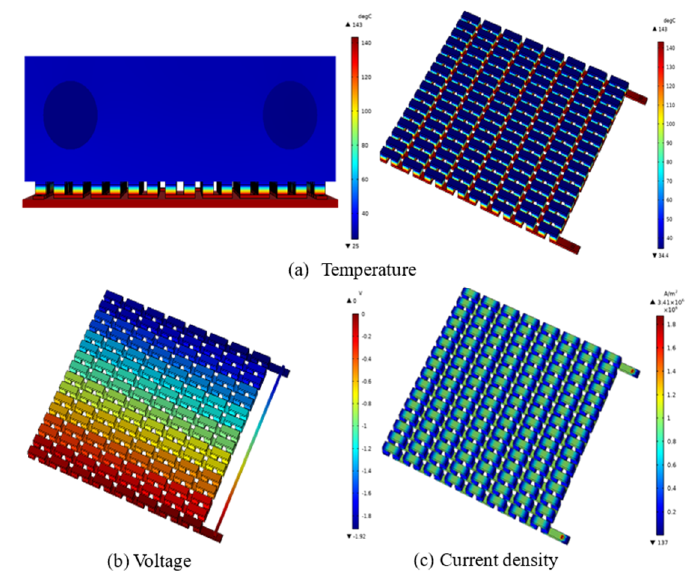
Figure 6. Numerical results of the TEG system. ( a ) Temperature distribution. ( b ) Voltage distribution. ( c ) Current distribution.